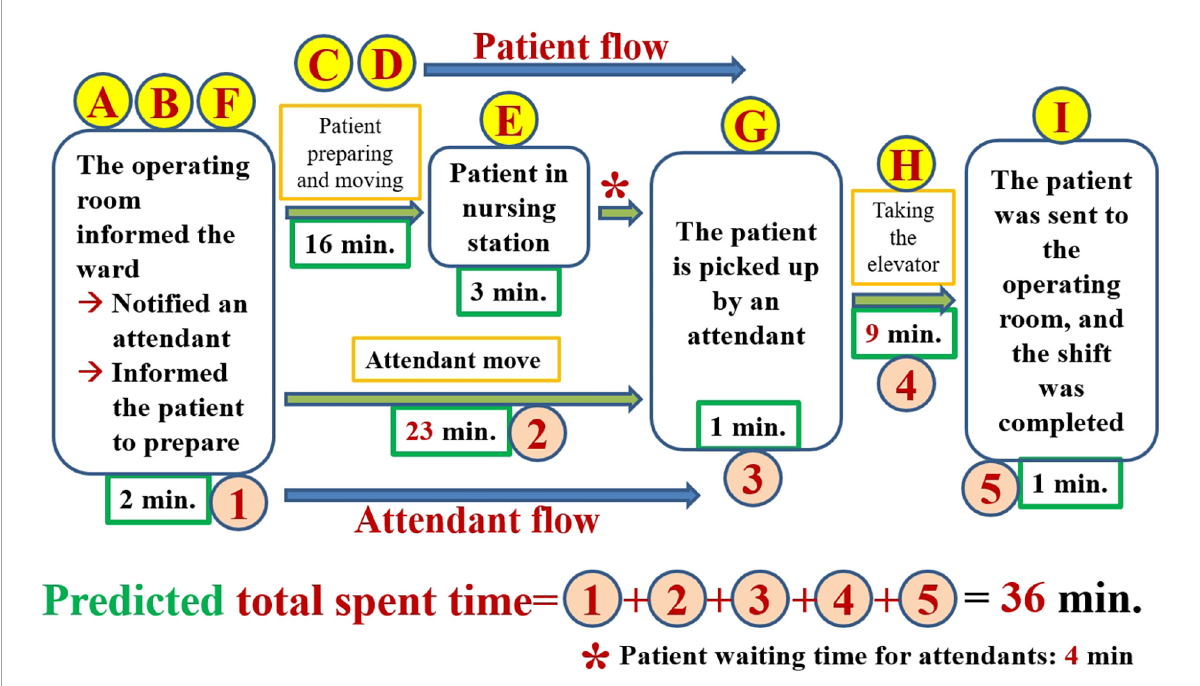
FIGURE6 The improved value stream map after combining and simplifying the rearranged process shown in Figure 5